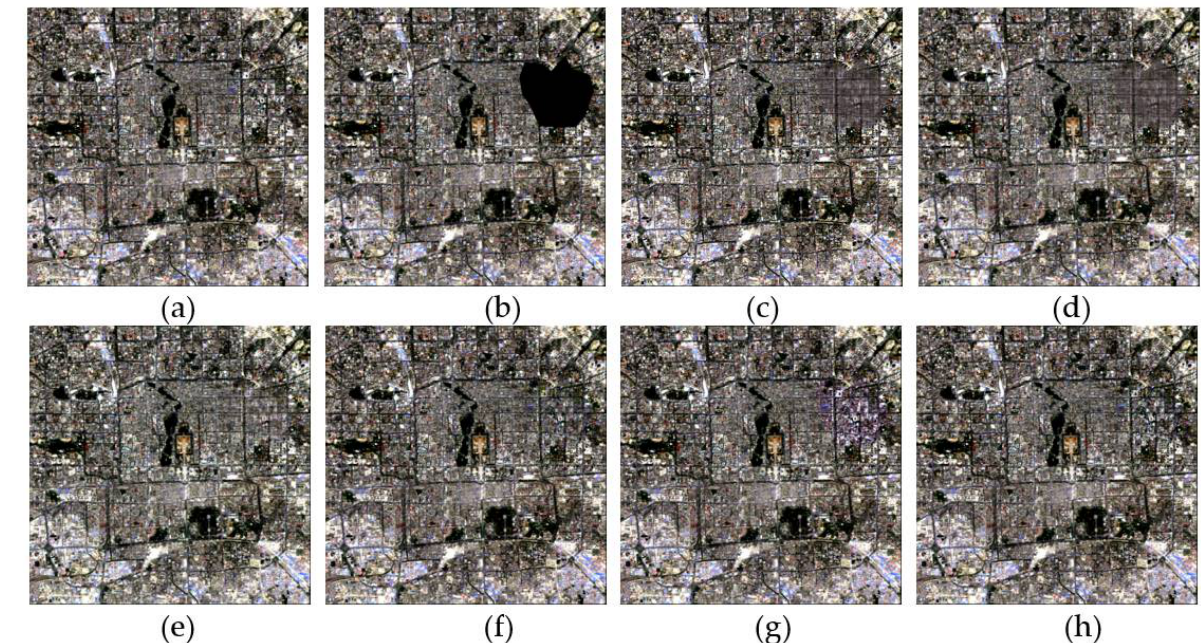
Figure 5. The simulated experiment performed on dataset 1: ( a ) original image; ( b ) simulated cloudy image; ( c – h ) reconstructed images with HaLRTC, AWTC, NL-LRTC, TVLRSD, ST-Tensor and FMTC algorithms, respectively.